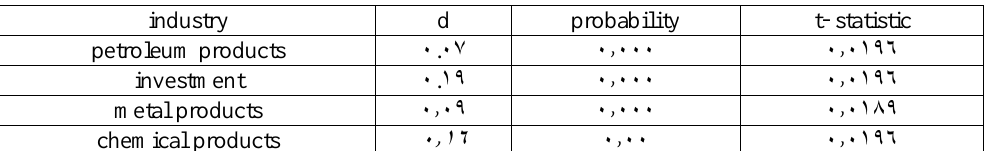
Table 4. GPH test